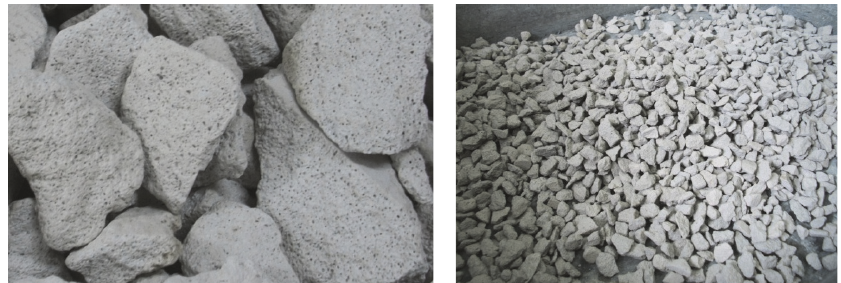
Figure 2: Crushed-AAC scraps into AAC aggregates.